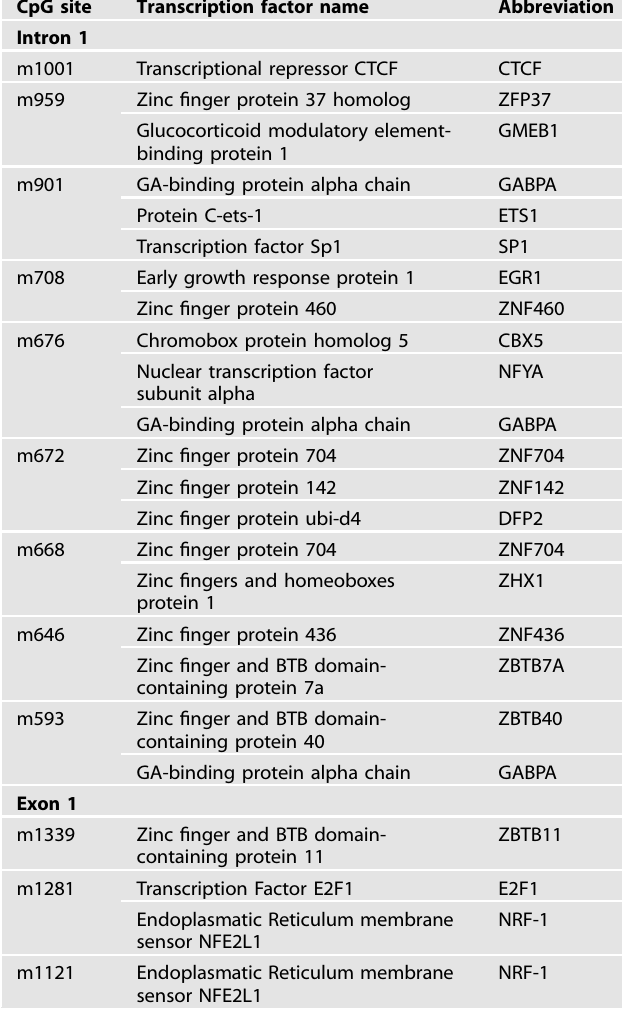
Table 3. Selection of transcription factors that could possibly bind to CpG sites where methylation differed signi fi cantly between the PWS group and the neurotypical controls (intron 1) or between PWS males with a history of psychosis and without history of psychosis (exon